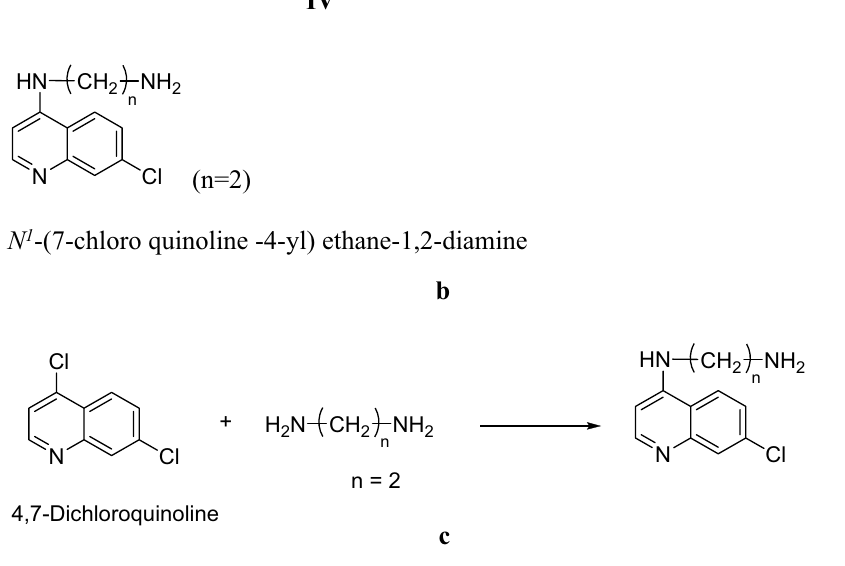
Figure 1. ( a ) 4,7-Dichloroquinoline design inspired by the natural molecule, chloroquine. ( b ) 4,7-Dichloroquinoline design inspired by the natural molecule, chloroquine. ( c ) 4,7-Dichloroquinoline design inspired by the natural molecule,